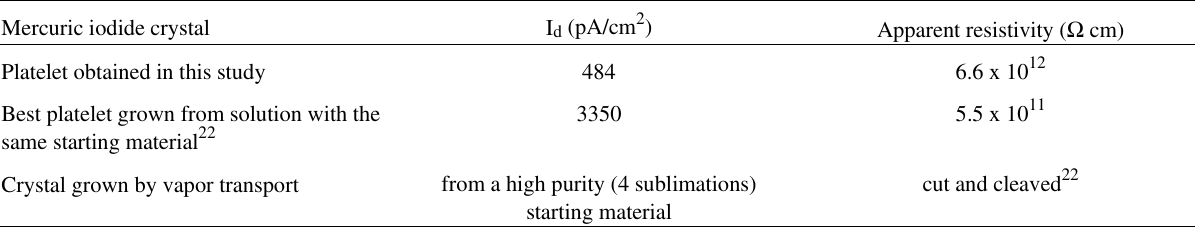
Table 1. Comparison of the electrical properties obtained for the detector assembled using the mercuric iodide platelet of Fig. 2a with the correspondent for other alternative growth